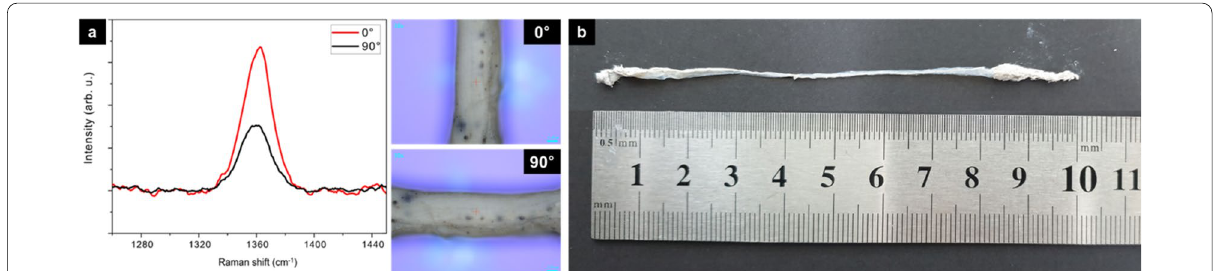
Fig. 7 a Raman spectra for the BNNT fiber at 0° and 90° under the VV mode. b As‑grown 10 cm long BNNT